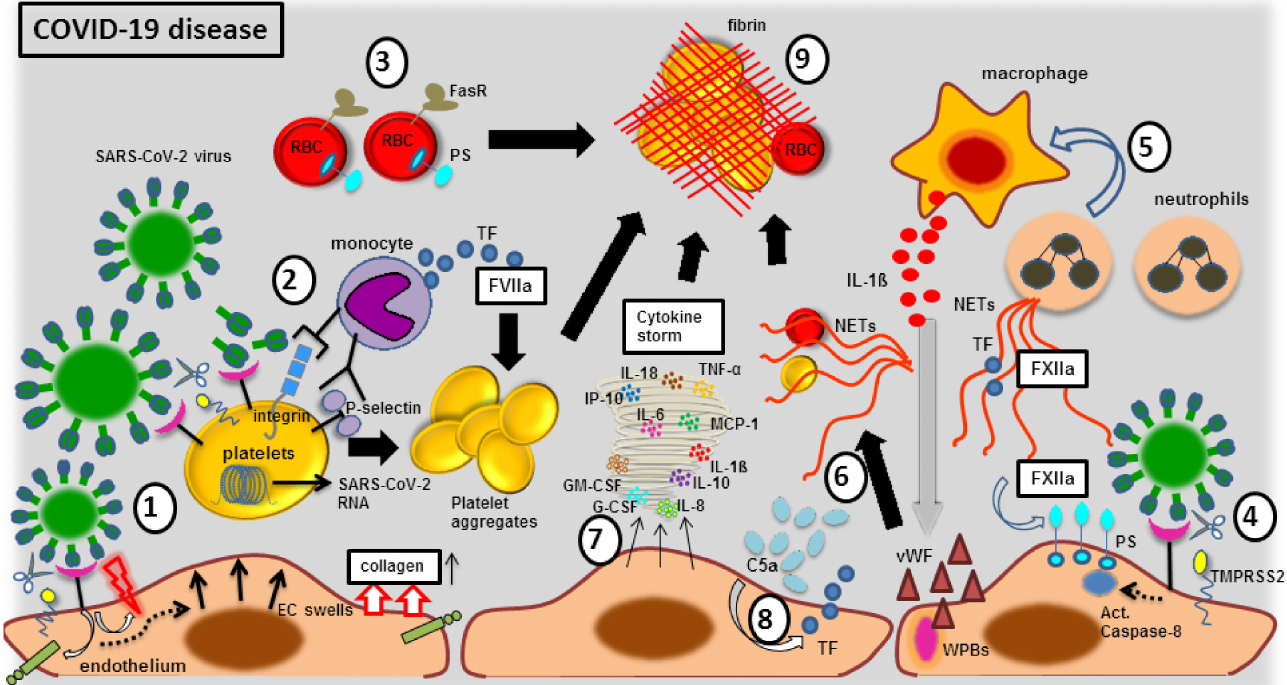
Figure 2. Potential molecular mechanisms involved in coagulopathy during SARS-CoV-2 infection. ( 1 ) When SARS-CoV-2 binds to ACE2 receptors expressed by endothelial cells (ECs), they damage the endothelial cell membrane, which leads to intracellular changes such as endothelium swelling, collagen exposure, and decreased junctional proteins. The collagen causes platelet aggregation and clot formation. ( 2 ) Since platelet expresses ACE2, SARS-CoV-2 binds to platelets and activates, as evidenced by the expression of activation and adhesion molecules, P-selectin and integrin, respectively. These adhesion molecules bind to circulating monocytes, which secretes tissue factor (TF) that is known to activate the extrinsic coagulation pathway and leads to clot formation. ( 3 ) The red blood cells (RBCs) that are recruited to the inflamed vasculature undergo changes in their symmetry and thereby expressed phosphatidylserine (PS), which might lead to thrombin formation. ( 4 ) SARS-CoV-2 induces caspase 8 in the endothelial cells, which expose PS on the cell surface. This attracts the FXIIa coagulation component to initiate clot formation. ( 5 ) The recruited neutrophil at the site of inflammation releases neutrophil extracellular traps (NETs) that contain TF and FXIIa. These NETs induce vessel resident macrophages to release IL-1 β pro-inflammatory cytokine that acts on vascular endothelium to liberate von Willebrand factor (vWF). Weibel-Palade bodies (WPBs) are elongated secretory organelles specific to endothelial cells that contain von Willebrand factor (vWF) and a variety of other factors. ( 6 ) These vWFs further induce NETs that serve as the docking site for platelets and RBCs. ( 7 ) These changes in the vascular microenvironment induce a massive amount of cytokine cocktail called “cytokine storm,” which ultimately induces a coagulation pathway to form a clot. ( 8 ) Further, complement C5b act on endothelium to induce TF, which leads to clot formation. ( 9 ) Cumulatively, the molecular and cellular mechanisms that are coordinately responsible for inducing and reinforcing the fibrin clot in COVID-19 positive